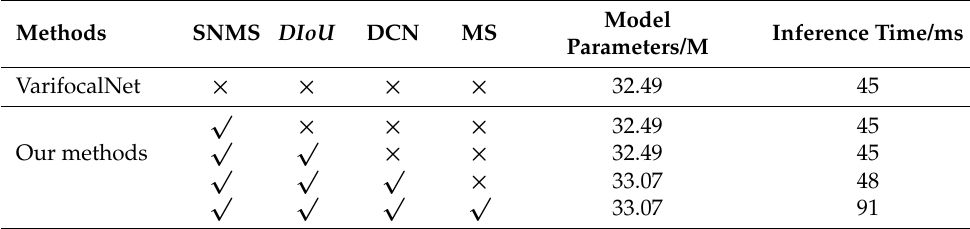
Table 4. Analysis of the impact of the improved module on the detection speed performance of the